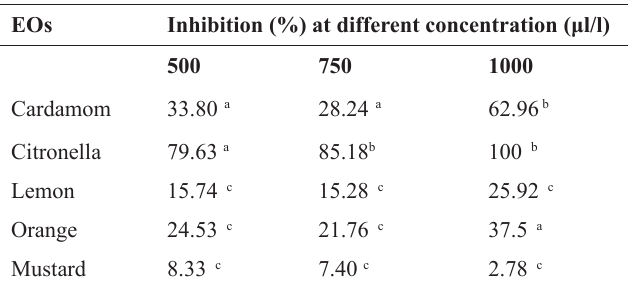
Table 2: Percentage mycelial growth inhibition of Lasiodiplodia sp. isolated from papaya on PDA, enriched with different essential oils, at the time when controls reached their maximum growth (90 mm colony diameter) at 48 h (day 2) after inoculation.